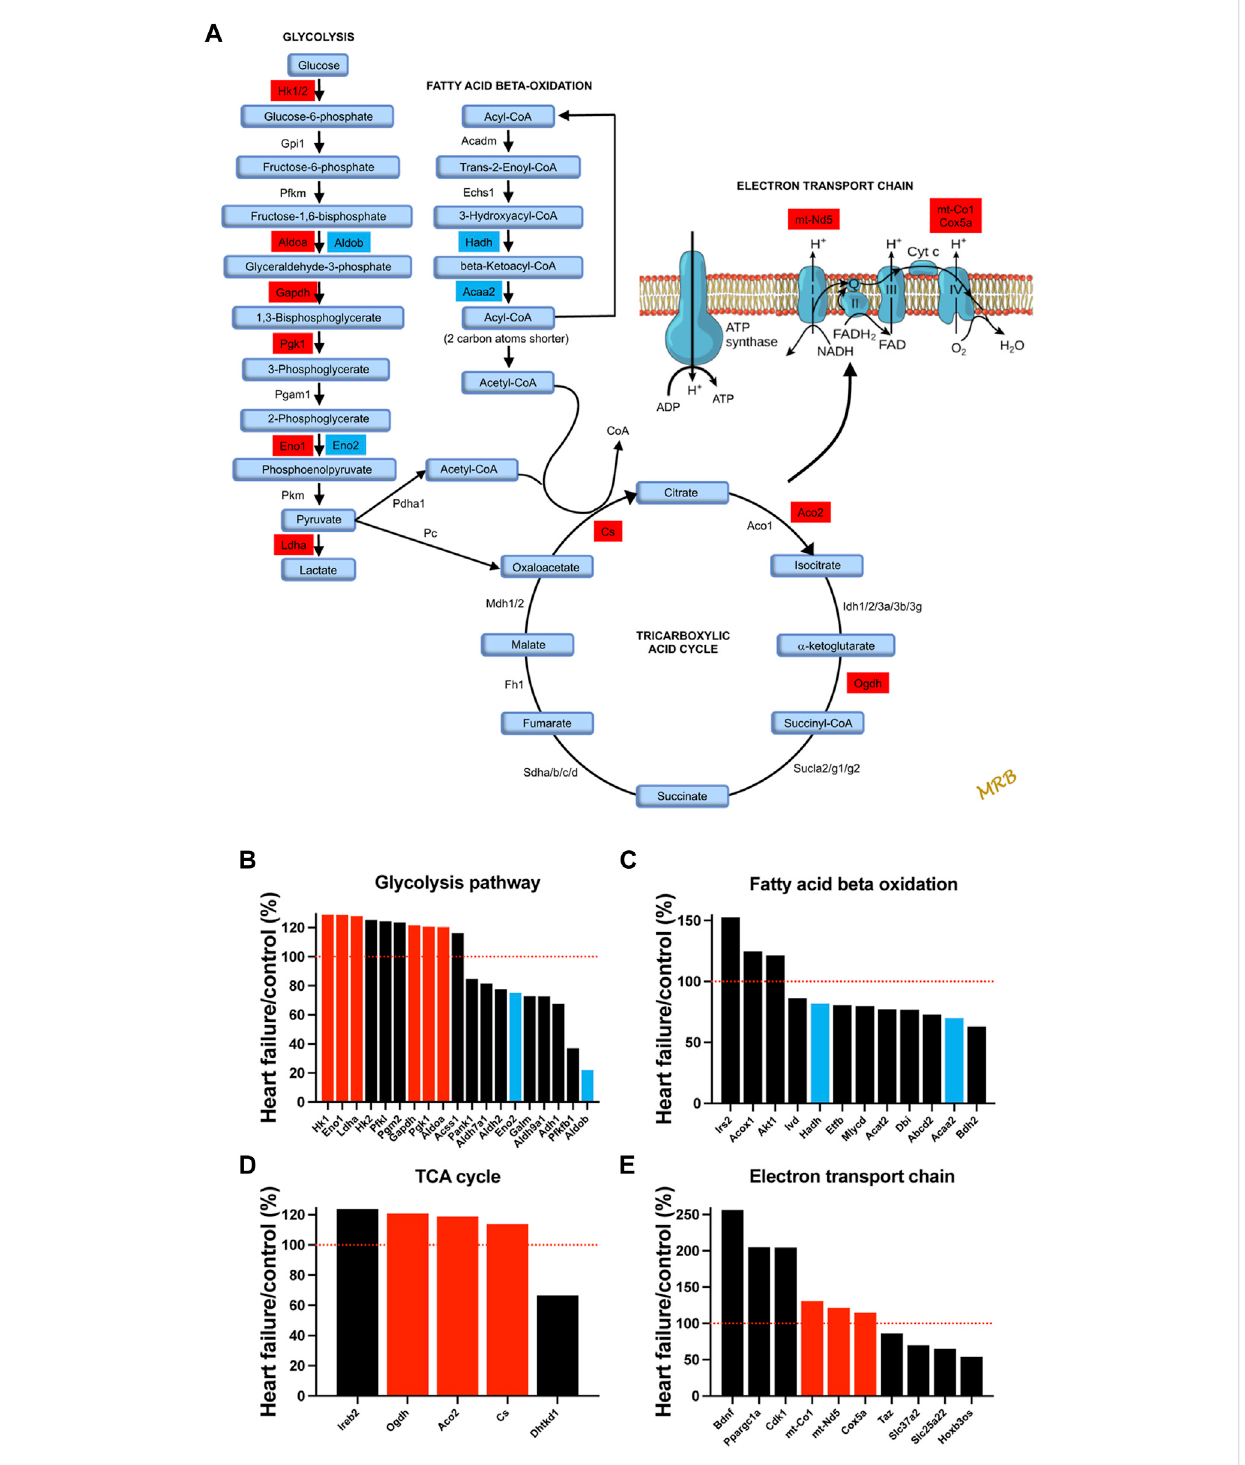
FIGURE 4 Evidence of a shift from fatty acid to glucose metabolism in the AV node in HF. (A) , schematic diagram of glycolysis, fatty acid beta-oxidation, the tricarboxylic acid cycle, and the electron transport chain. For glycolysis, fatty acid beta-oxidation, and the tricarboxylic acid cycle, key enzymes and metabolic intermediaries (in light blue) are shown. Transcripts of enzymes highlighted in red were signi fi cantly upregulated in HF and transcripts of enzymeshighlightedindark blueweresigni fi cantlydownregulated. Fortheelectron transport chain,ATPsynthaseandcomplexesItoIVareshown. Transcripts associated with complexes I and IV were signi fi cantly upregulated and are highlighted in red. (B – E) , expression of transcripts associated with glycolysis (B) ,fattyacidbeta-oxidation (C) ,thetricarboxylicacidcycle (D) andtheelectrontransportchain (E) inHFmiceasapercentageofthatincontrol mice. All transcripts changed signi fi cantly in HF. Signi fi cantly upregulated transcripts highlighted in A are shown in red and signi fi cantly downregulated transcripts highlighted in A are shown in blue. Red dotted lines correspond to